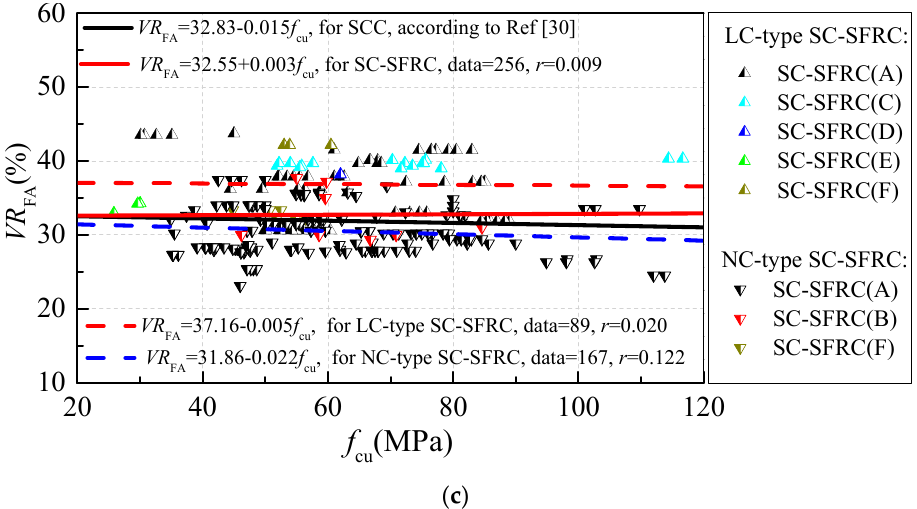
Figure 1. The differences of volume fraction of aggregates: ( a ) VR A ; ( b ) VR CA ; and ( c ) VR FA.